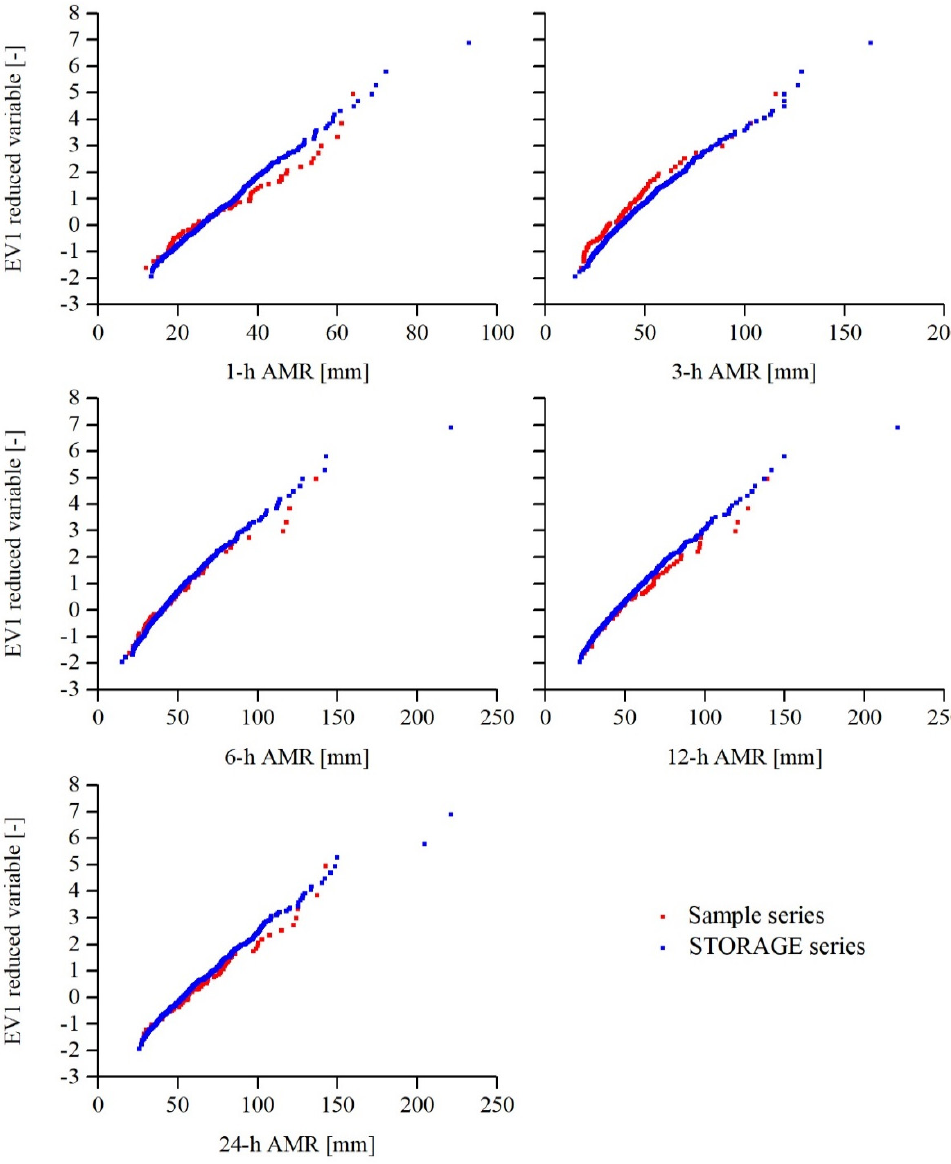
Figure 2. Brindisi rain gauge: EV1 (extreme value distribution of type 1, also named as Gumbel distribution) probabilistic plots, showing the comparison among synthetic and observed AMR series, under the hypothesis of stationary process.